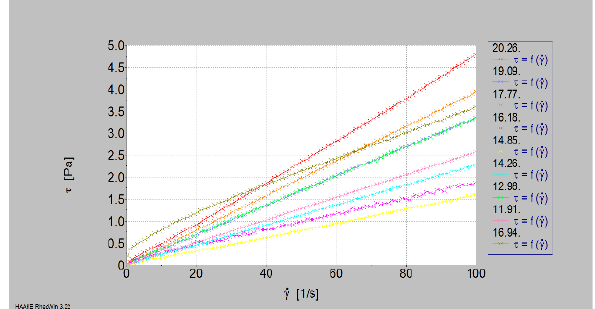
Figure 6: Rheological behavior of alkaline activation